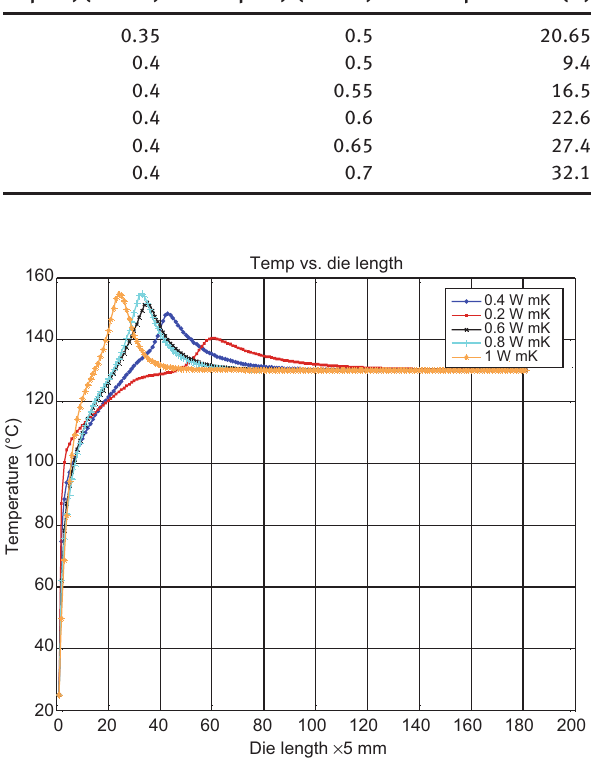
Figure 7 Temperature curve with thermal conductivity variations at 0.2 m min -1